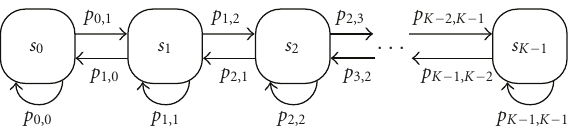
Figure 2: Multistate Markov channel